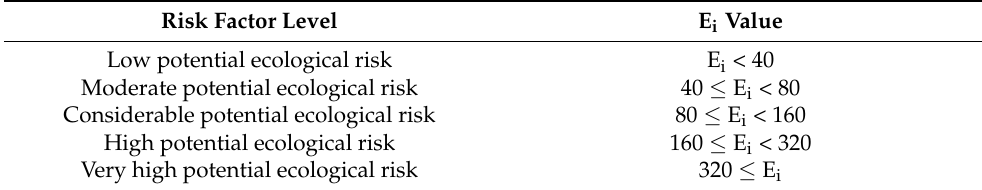
Table 4. Classification for the Potential Ecological Risk Factor (E i ) [29]. Risk Factor Level E i Value Low potential ecological risk E i < 40 Moderate potential ecological risk Considerable potential ecological risk High potential ecological